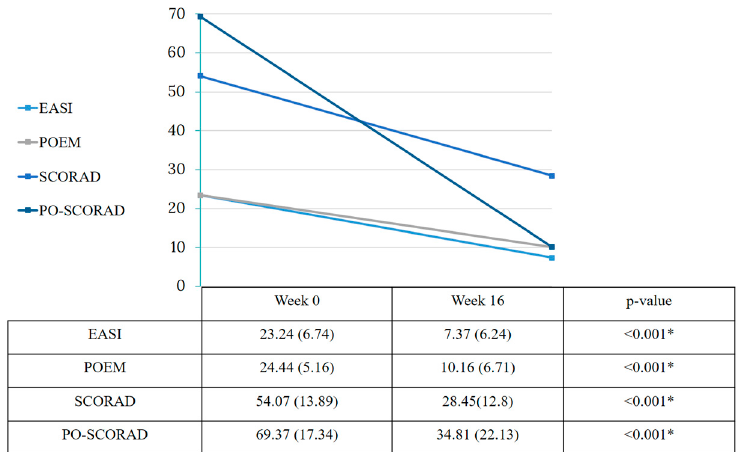
Figure 1. Effect of dupilumab on AD severity in week 0 and 16. Two-tailed * p < 0.05 was considered statistically significant in all tests.